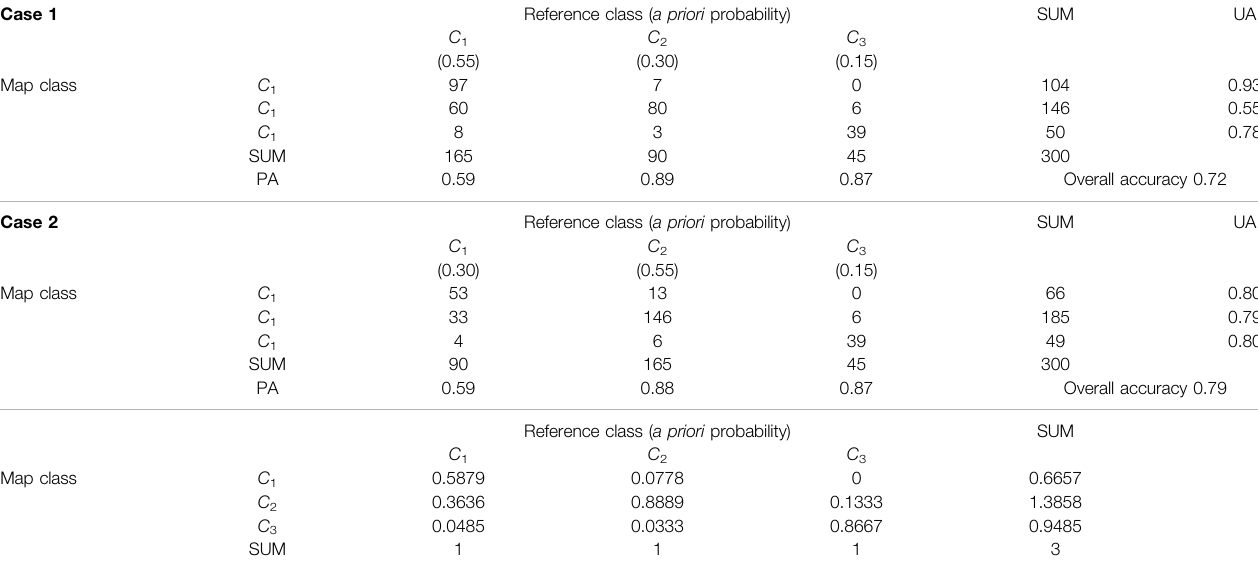
TABLE 7 | Example of changes in user accuracy (UA) caused by changes in the percentage proportions ( a priori probabilities) of class-speci fi c training data (cases 1 and 2). Case